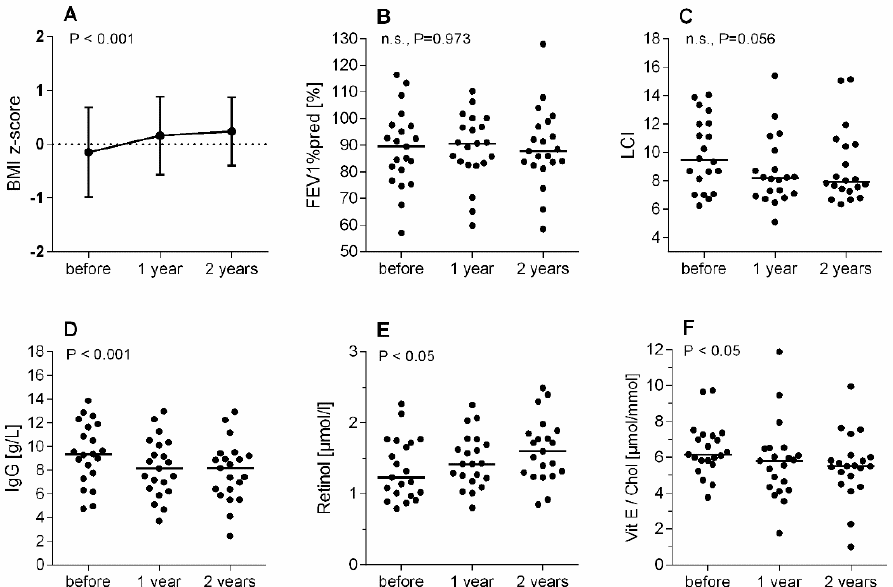
Figure 2. Course of selected clinical parameters and fat-soluble vitamins over two years of therapy with lumacaftor/ivacaftor (LUM/IVA) in a cohort of 21 patients with CF. ( A ) BMI z-scores given as mean ± SD. ( B ) Forced expiratory volume in one second in percent predicted (FEV1%pred), ( C ) Lung clearance index (LCI), ( D ) immunoglobulin G (IgG), ( E ) retinol, and ( F ) ratio of vitamin E and cholesterol. Values in ( B – F ) are presented as single values and median. Results with p < 0.05 are statistically significant. Abbrevations: n.s. = not significant.